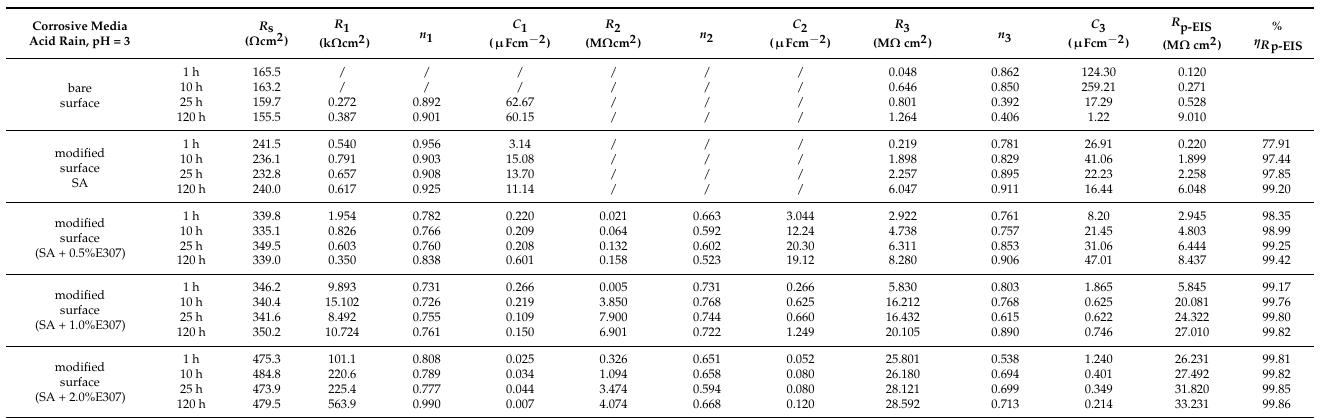
Table 2. Electrochemical impedance parameters (EIS fitting results) for SS AISI 410S (for the bare and modified surfaces) after immersion in simulated solution of acid rain with pH = 3 for different times at 25 ◦